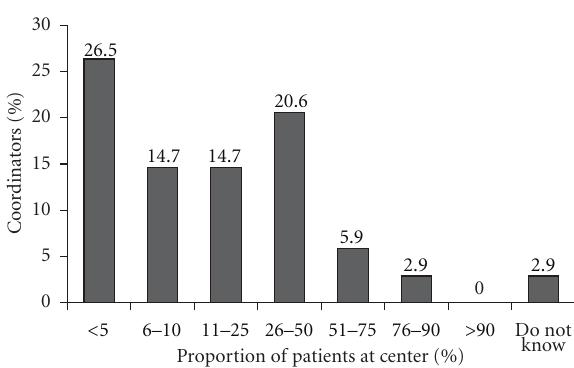
F 5: Transplant coordinator-reported proportion of trans- plant recipients experiencing adverse events during maintenance immunosuppression